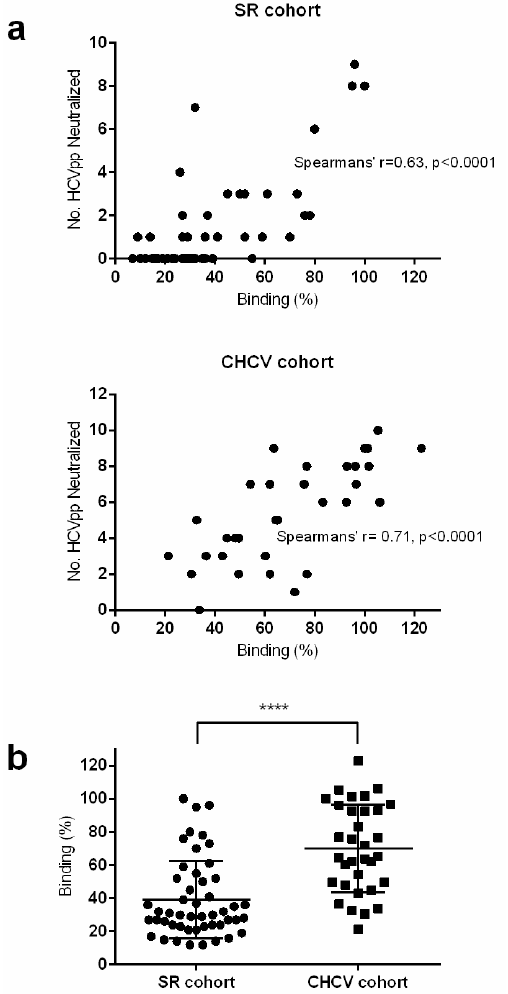
Figure 2. Correlation of binding and neutralization. ( a ) For each sample, the relative binding (%) to gt1a H77 E1E2 lysate was plotted against the number of HCVpp that were neutralized. SR cohort (top panel) and CHCV cohort (lower panel). Spearman’s rho correlation was plotted for both graphs. ( b ) The relative binding (%) to gt 1a H77 E1E2 lysate of samples within both cohorts were plotted. A parametric t -test was used to compare binding between both groups, (**** denotes that the p-value is less than